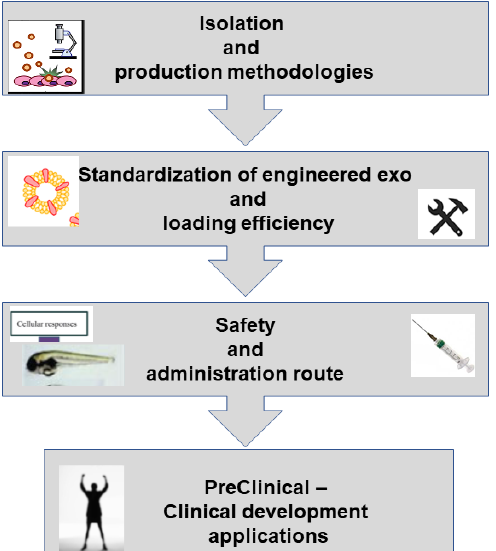
Figure 11. Different stages and challenges in the development of EV-based therapeutics. From the industrial-scale production of clinical-grade exosomes to the loading approaches and preservation of exosome biocompatibility, these bottlenecks need great efforts to accelerate the road to clinic.